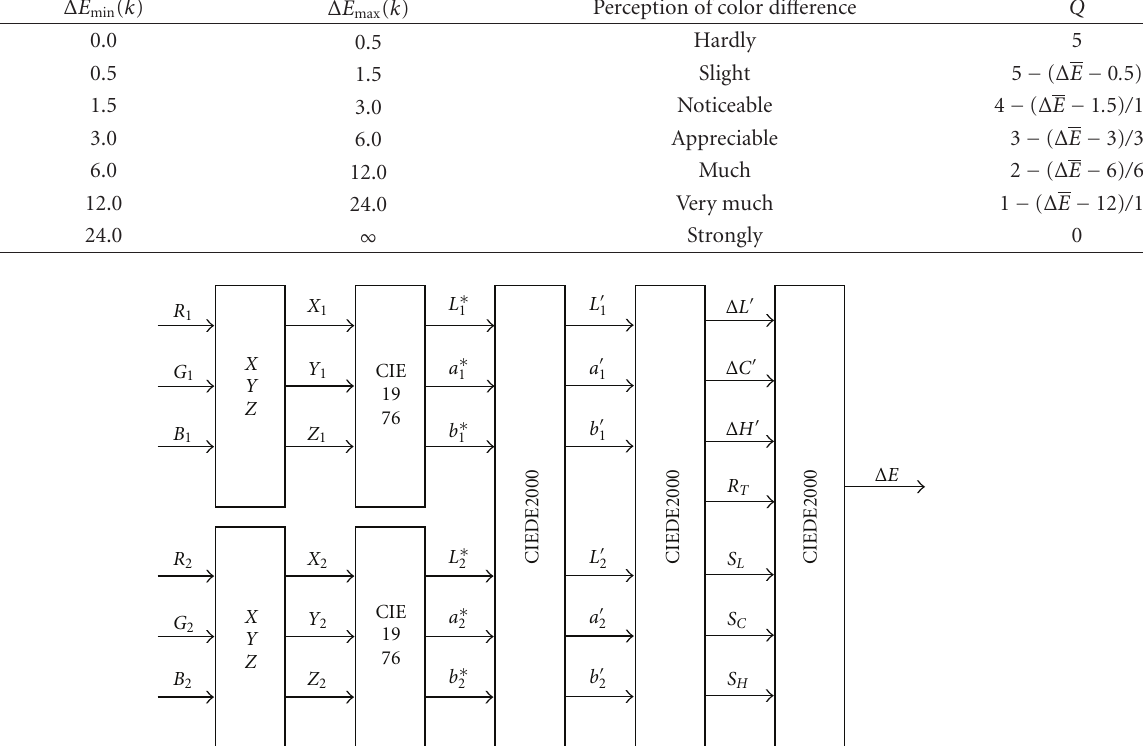
Figure 1: CIEDE2000 color di ff erence formula step diagram.